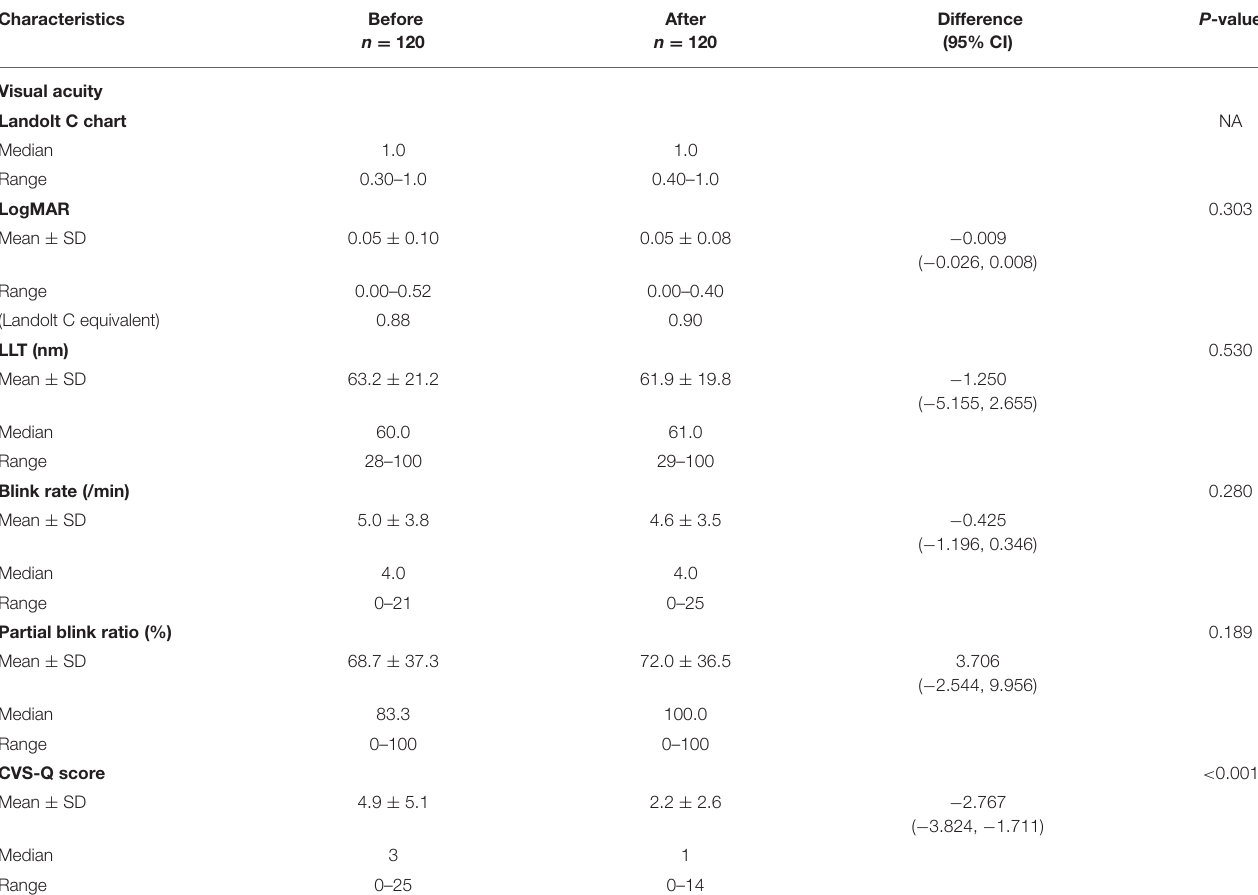
TABLE 2 | The ocular parameters before and after watching a movie for 15min.